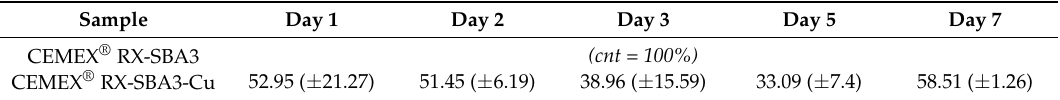
Bacteria cultivated onto copper-doped specimens (CEMEX ® RX-SBA3-Cu) % of viability in comparison with untreated control (CEMEX ® RX-SBA3). Data are expressed as means ± standard